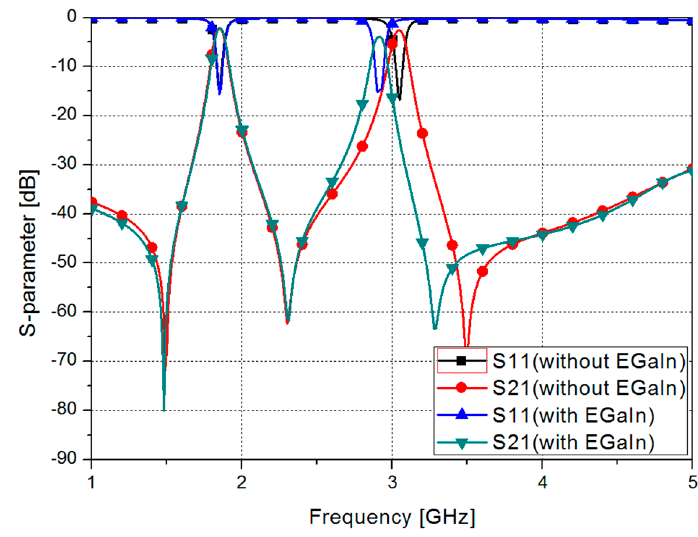
Figure 4. Simulated S-parameters of the proposed filter.